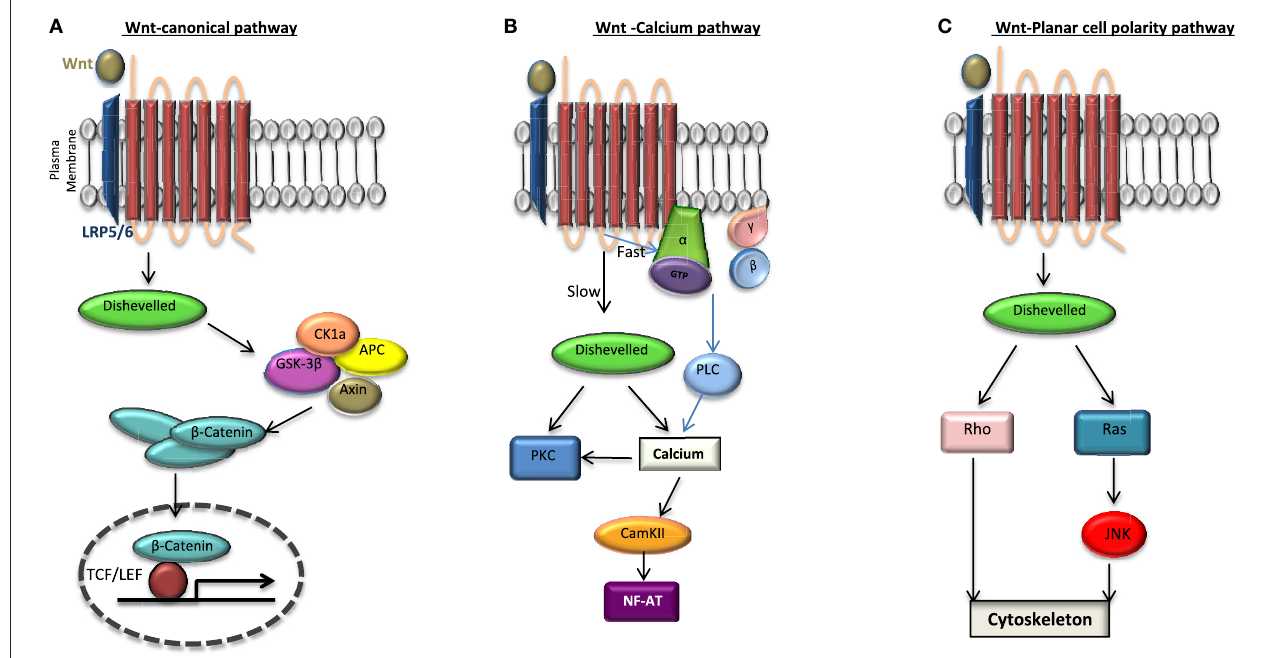
FIGURE 2 | Wnt signaling pathways. When Frizzled receptor (FZD) is bound to its agonist Wnt it can activate one of the three pathways: (A) the canonical pathway in which the activation of disheveled (DVL) leads to the disassembly of the destruction complex; axin, adenomatosis polysis coli (APC), glycogen synthase kinase 3 β (GSK3 β ) from β -catenin. This in turn increases the cytosolic level of β -catenin which is then translocated to the nucleus and binds to transcription factor T-cell factor/lymphoid enhancer factor (TCF/LEF) activating the transcription of target genes. β -catenin is phosphorylated by GSK3 β and degraded when there is no Wnt activation of FZD. Non canonical pathways include (B) Wnt-Calcium pathway in which DVL activates protein kinase C (PKC) leading to the release of intracellular calcium thereby activating a calcium/calmodulin-dependent protein kinase II (CaMKII) and (C) Wnt-planar cell polarity pathway in which the activation of DVL signals to Rho GTPases (Rho or Rac or both). While Ras activation is signaled through the c-Jun amino (N)-terminal kinase (JNK), the activation of Rho-GTPases induces changes in the cytoskeleton. To date it has been found that Wnt signaling can not only lead to a direct activation of DVL independent of the heterotrimeric G proteins as seen in (A) but may also lead to a G protein-DVL dependent activation whereby DVL can bind to or become activated subsequently by the G proteins in the